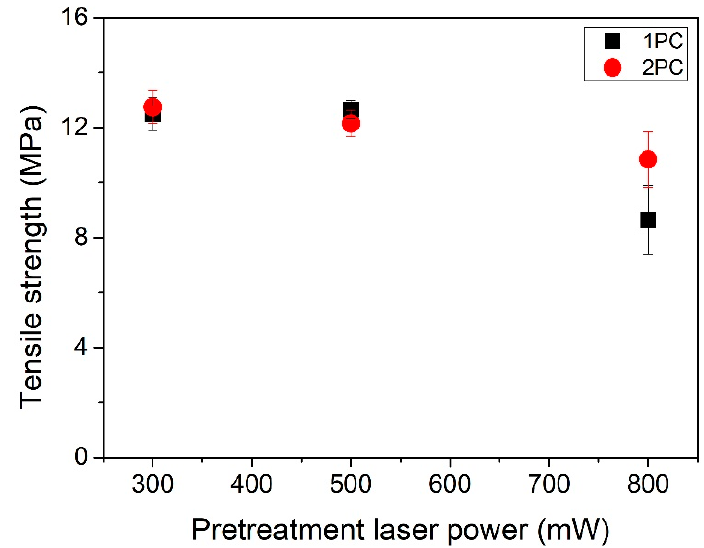
Figure 9. Effect of the pretreatment laser power on tensile strength.